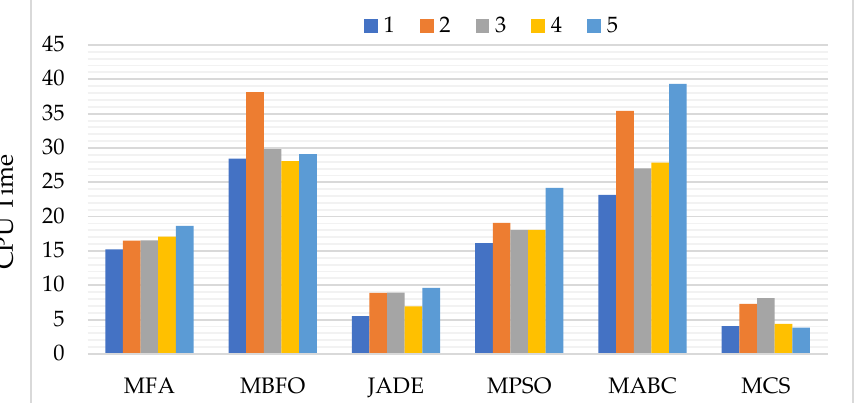
Figure 6. CPU time using different optimization algorithms with MCE.